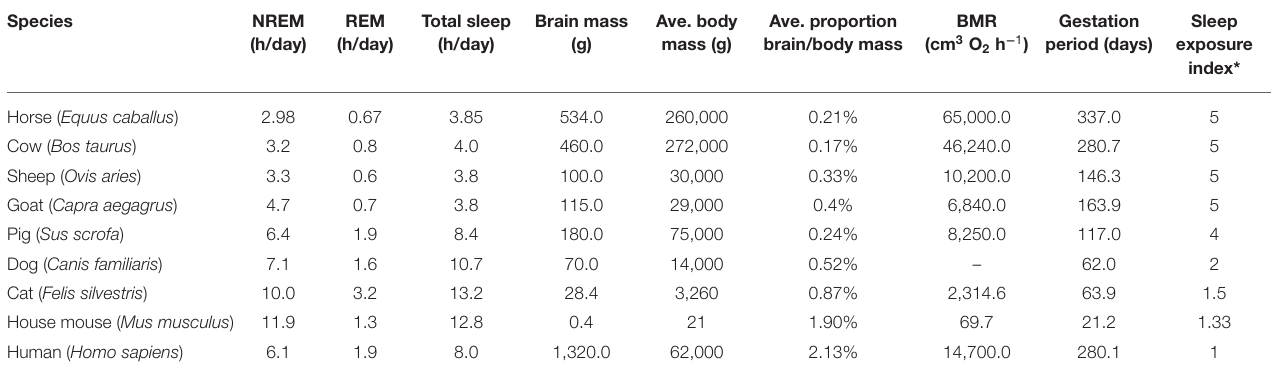
TABLE 1 | Comparison between sleep profiles and biological characteristics of various bi-hemispheric species, ordered by high to low sleep exposure indices (3, 20, 21).